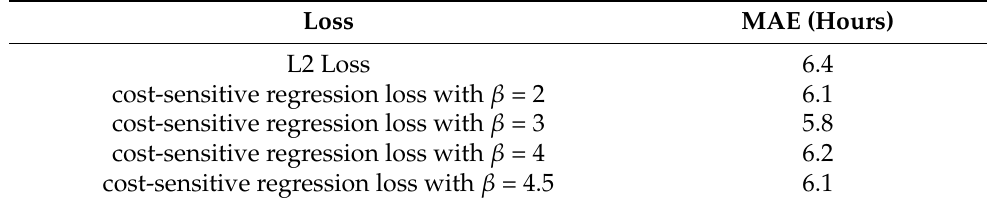
Table 5. The performance of different loss functions and different values of β based on data expansion and deep residual regression